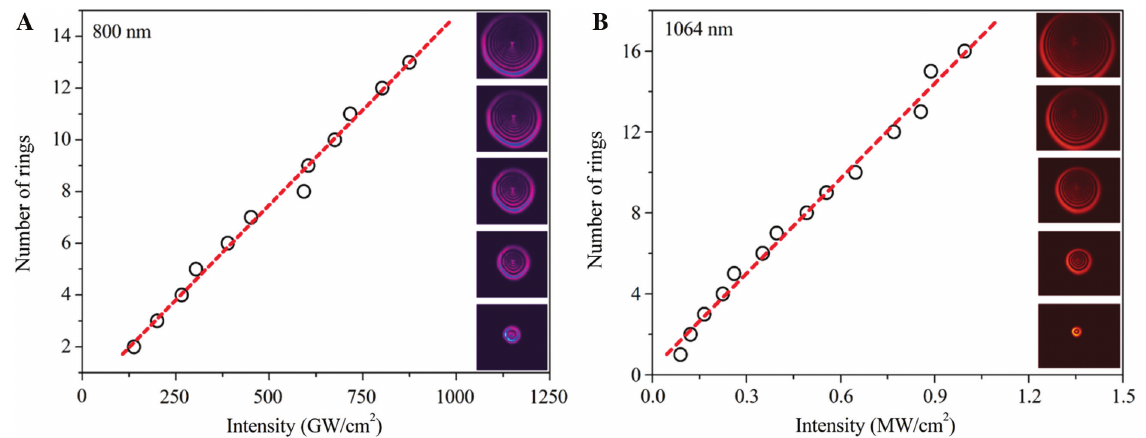
Figure 3: The relationship between N and I under different laser illumination. (A) 800 nm and (B) 1064 nm wavelength ultrafast lasers. Table 1: Third-order optical susceptibilities of the reported materials. Sample